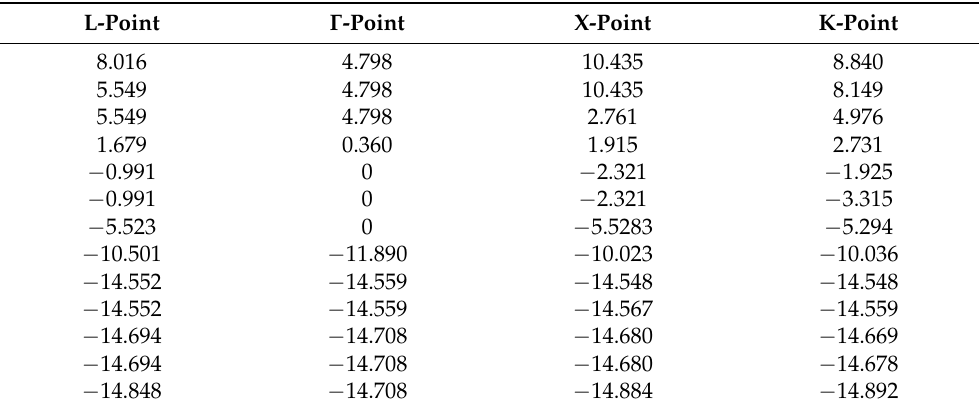
Table 3. Calculated, electronic energies of zb-InAs at high symmetry points in the Brillouin Zone obtained with the optimal basis set of Calculation IV. We used the experimental lattice constant of 6.0583 Å. This table is partly to enable comparisons with future room temperature, experimental and theoretical results. Γ -Point